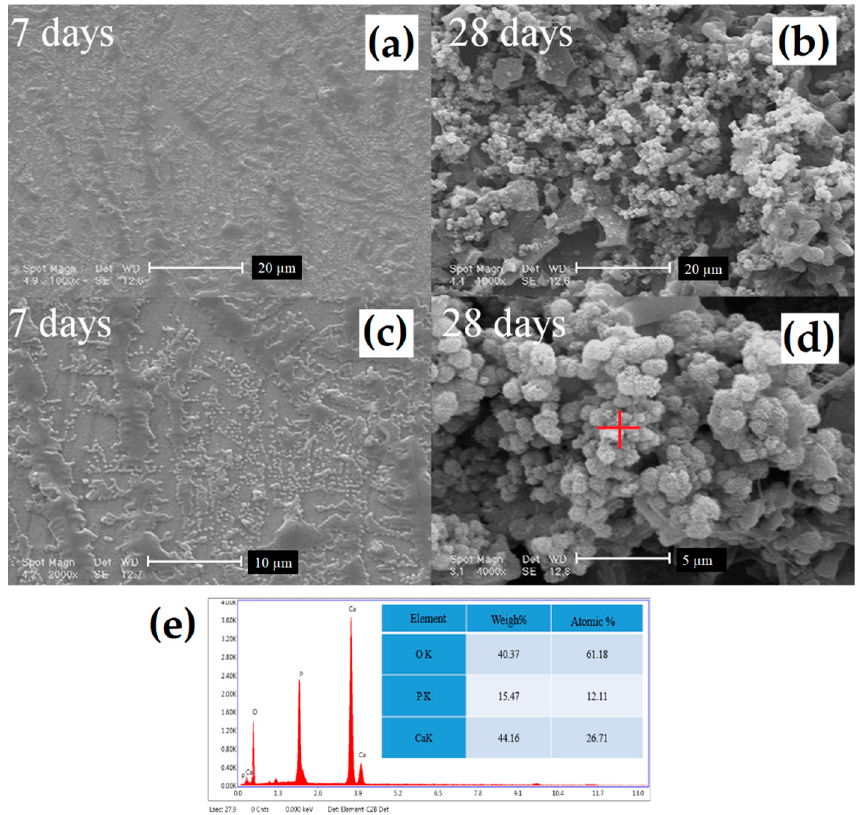
Figure 6. SEM micrographs of the surface of 3BG / GE / PCL samples after soaking in SBF solution for ( a , c ) 7 days and ( b , d ) 28 days. ( e ) The EDS results of the 3BG / GE / PCL sample after 28 days of immersion in the SBF solution.